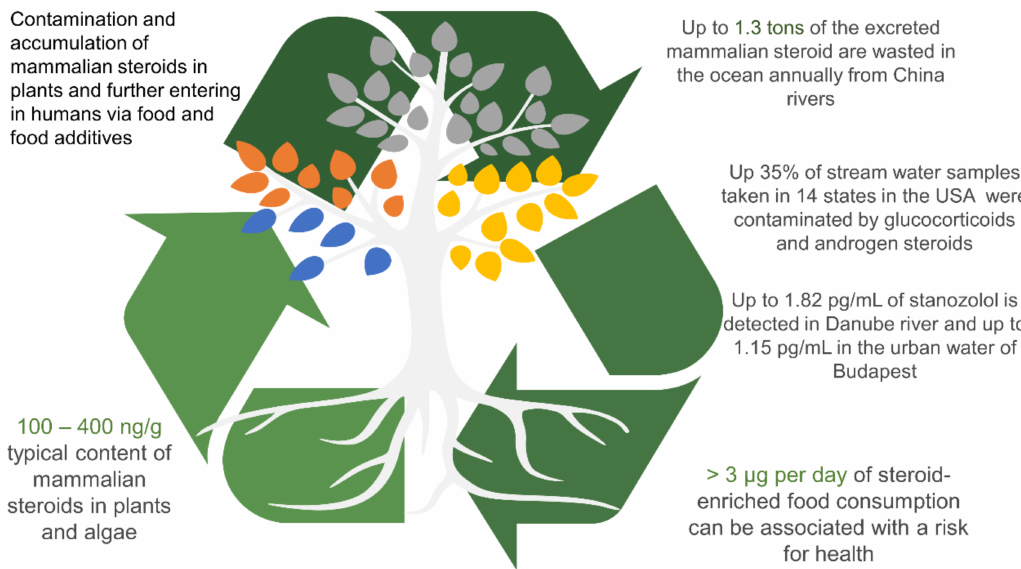
Figure 4. It is hypothesized that mammalian-like steroids found in plants are contaminants that enter the plant through the soil and reclaimed water. Up to 1.3 tons of the excrete mammalian steroids (endogenous and synthetic) are wasted in the ocean from China rivers. In the USA, glucocorticoids (hydrocortisone and prednisone) and androgen steroids were found in 27 to 35% of stream water samples taken from 14 states. These polluting steroids enter plants, fungi, and soil microbial cells and can be highly toxic for plants due to low solubility. The absorbed steroids can be accumulated in plant organs (roots, leaves) and consumed by humans. According to the WHO recommendations, the risk associated with steroid-enriched food consumption is considered only if their intake exceeds 3 µ g per day. However, it is believed that the specific content of contaminating steroids in plants is 100 to 400 ng/g of plant